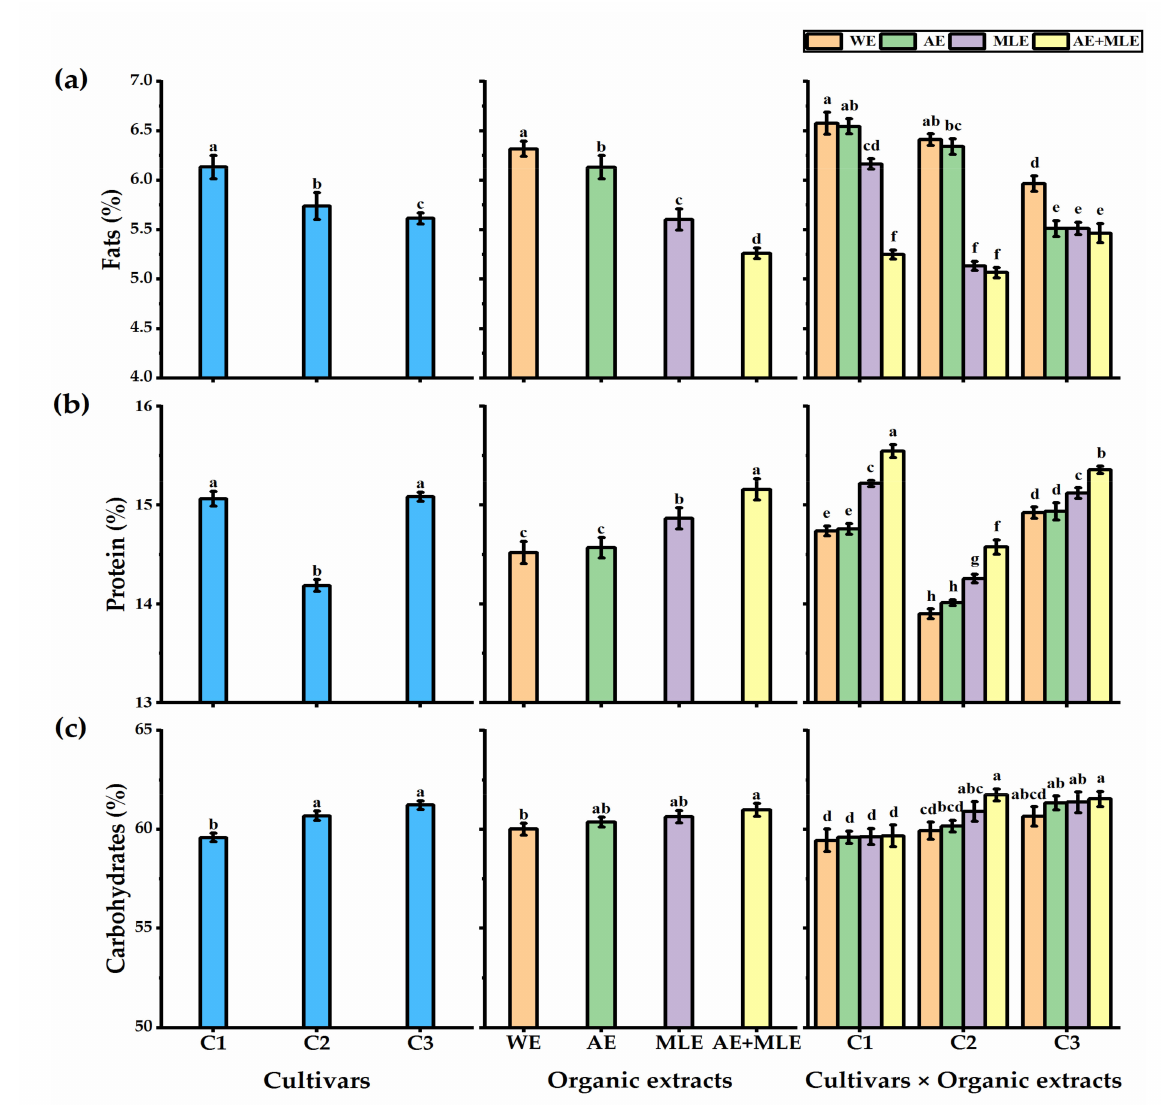
Figure 4. Effect of Azolla extract, moringa leaf extract, and their combination on ( a ) fats (%), ( b ) protein (%), and ( c ) carbo- hydrates (%) of three quinoa cultivars. C1 = KVL − SRAZ, C2 = Chipaya, C3 = Q − 37, WE = without extract, AE = Azolla extract, MLE = moringa leaf extract. Data are mean value ± SE, n = 3. Different letters denote significant differences at p ≤ 0.05